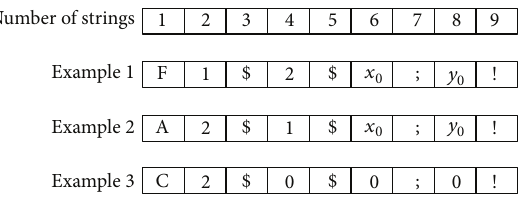
Figure 6: Message format in robots communication.